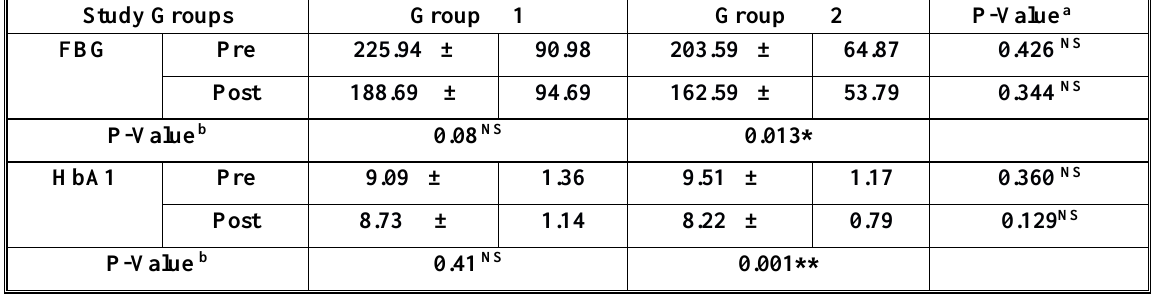
Figure 1. Effect of treatment on MNSI in Patients with diabetic neuropathy. Table 3. Effect of treatment on FBG & HbA 1c levels in patients with diabetic neuropathy.